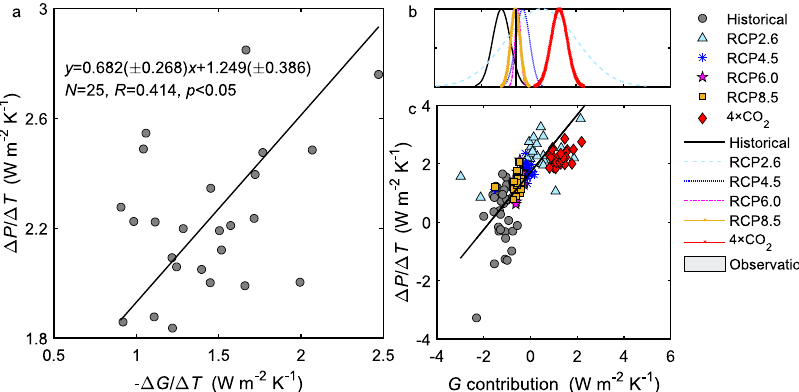
Fig. 5 Relationship between global precipitation temperature sensitivity and temperature sensitivity of ocean heat storage. a Dependence of precipitation temperature sensitivity ( Δ P / Δ T ) on climate feedback strength for the 4 × CO 2 scenario. The climate feedback strength is approximated by a negative value of temperature sensitivity of ocean heat storage ( − Δ G / Δ T ) from 4 × CO 2 scenario. b Gaussian probability distribution of the ocean heat storage ( G ) contribution to Δ P / Δ T . c Relationship between precipitation temperature sensitivity and G contribution [ (cid:2) 1 = ð 1 þ β Þð Δ G = Δ T Þ ] across models and scenarios. The observational range (mean ± one standard deviation) is denoted by the gray bar. Solid lines are regression fi t. The regression slope in c (0.982) is increased to 1.290 if the 4 × CO 2 results are excluded. Description of model scenarios is given in Fig. 1